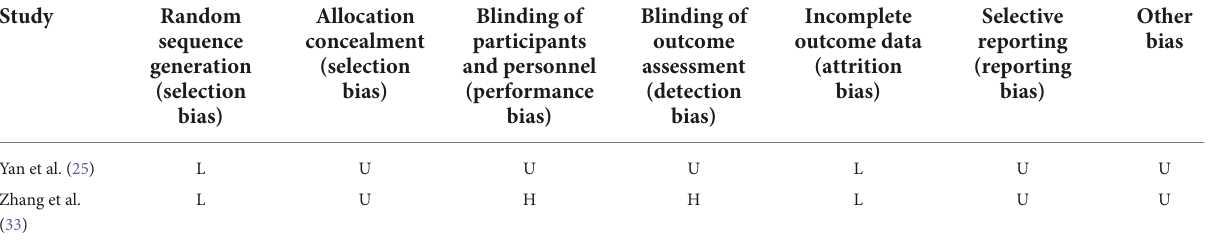
TABLE 2 The risk of bias of included randomized controlled